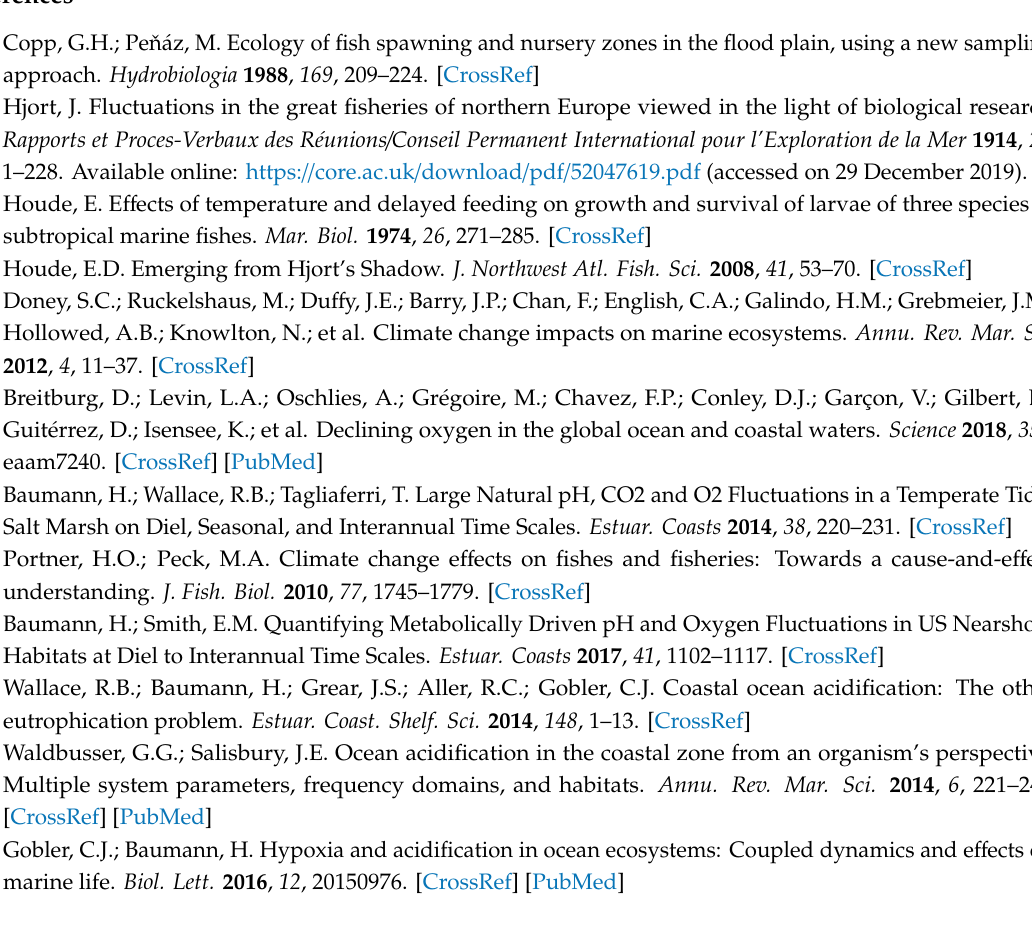
diurnal duration acidification and hypoxia experiment, Table S23: One way Anova results for survival (normalized to # fish hatched per vessel, arcsin trasnformed) of Menidia beryllina II larvae in the four treatment diurnal duration acidification and hypoxia experiment, Table S24: ANOVA analysis of Deviance for linear mixed e ff ects model comparing model with (full) and without (null) treatment e ff ects for length of Menidia beryllina II larvae in the four treatment diurnal duration acidification and hypoxia experiment, Table S25: Analysis of Deviance for GLM fitted model for hatch time of Menidia menidia larvae in the four treatment diurnal duration acidification and hypoxia experiment, Table S26: One way Anova results for hatch success (arcsin transformed) of Menidia menidia larvae in the four treatment diurnal acidification duration and hypoxia experiment, Table S27: One way Anova results for survival (normalized to # fish hatched per vessel, arcsin transformed) of Menidia menidia larvae in the four treatment diurnal duration acidification and hypoxia experiment, Table S28: ANOVA analysis of Deviance for linear mixed e ff ects model comparing model with (full) and without (null) treatment e ff ects for length of Menidia menidia larvae in the four treatment diurnal duration acidification and hypoxia